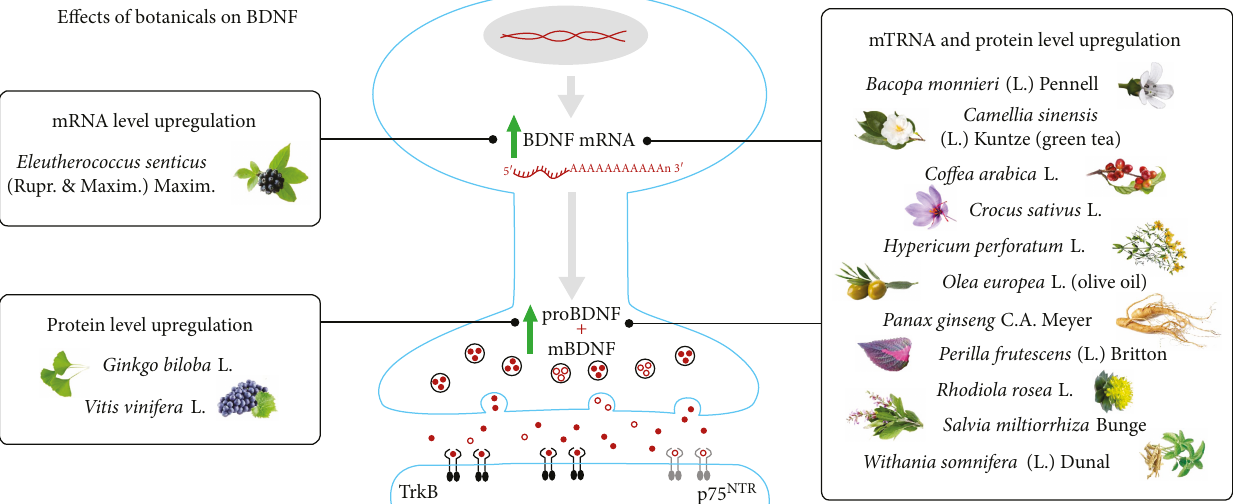
Figure 1: E ff ects of botanicals on BDNF mRNA and protein levels. The fi gure shows botanicals acting at transcriptional and translational